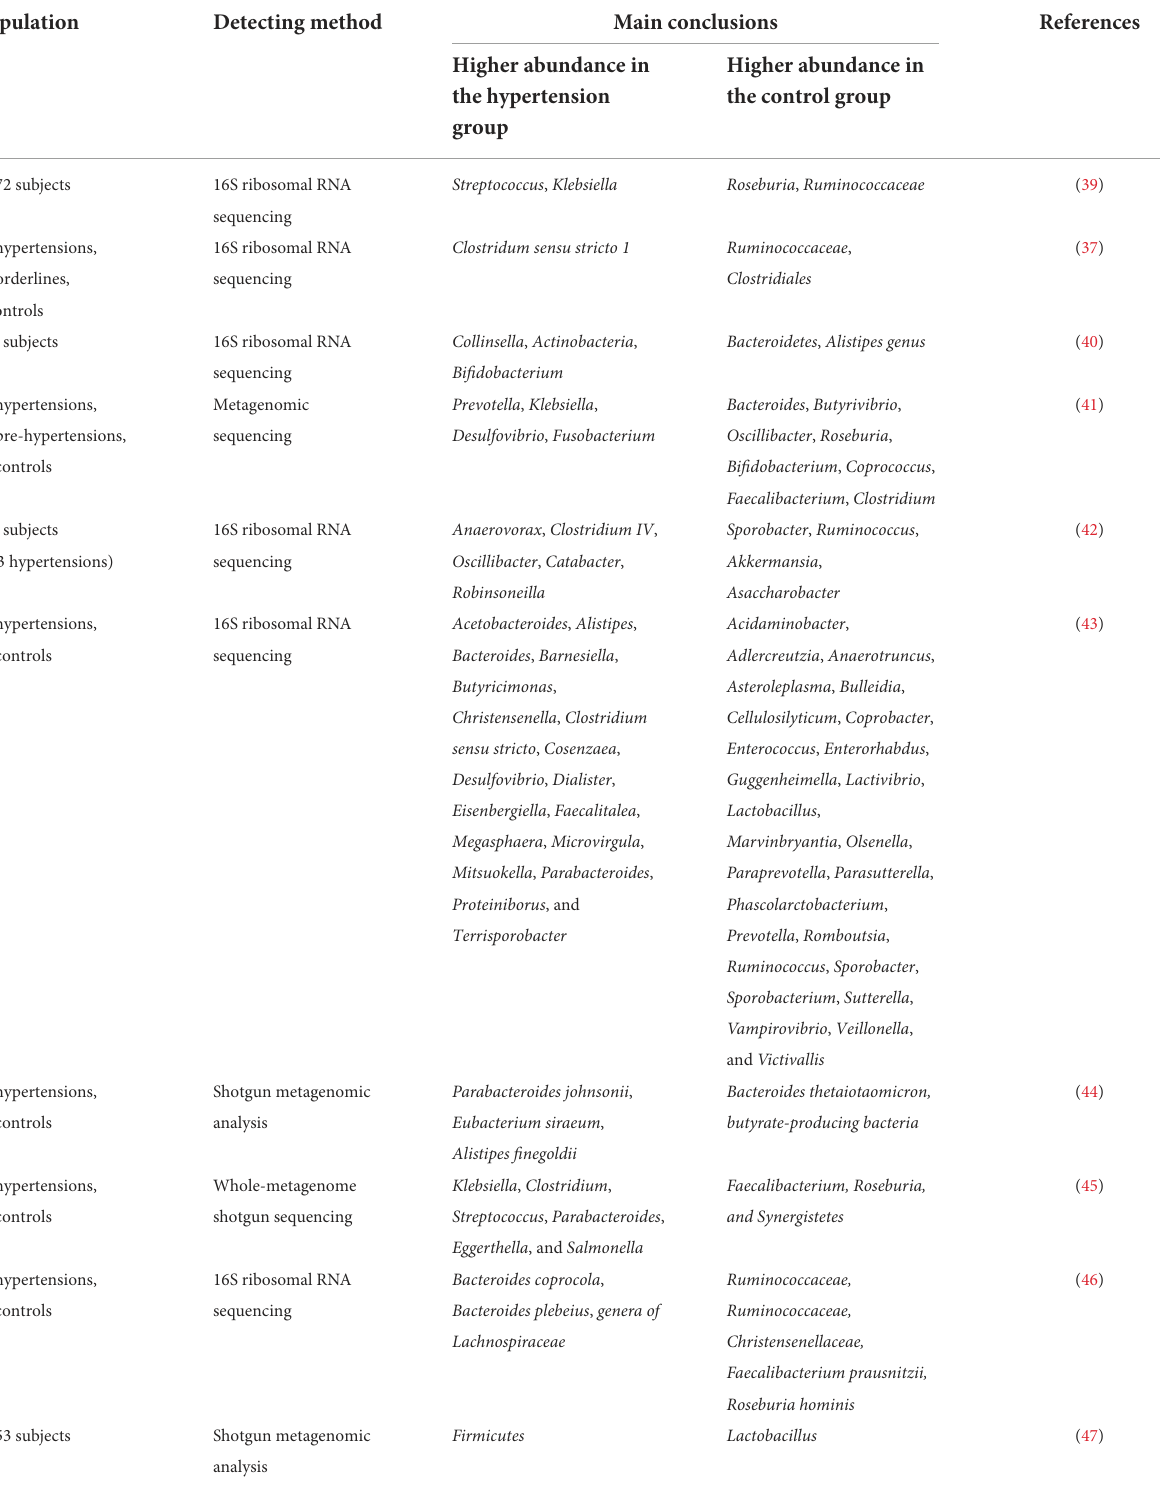
TABLE 2 Composition of intestinal microbiota in patients with